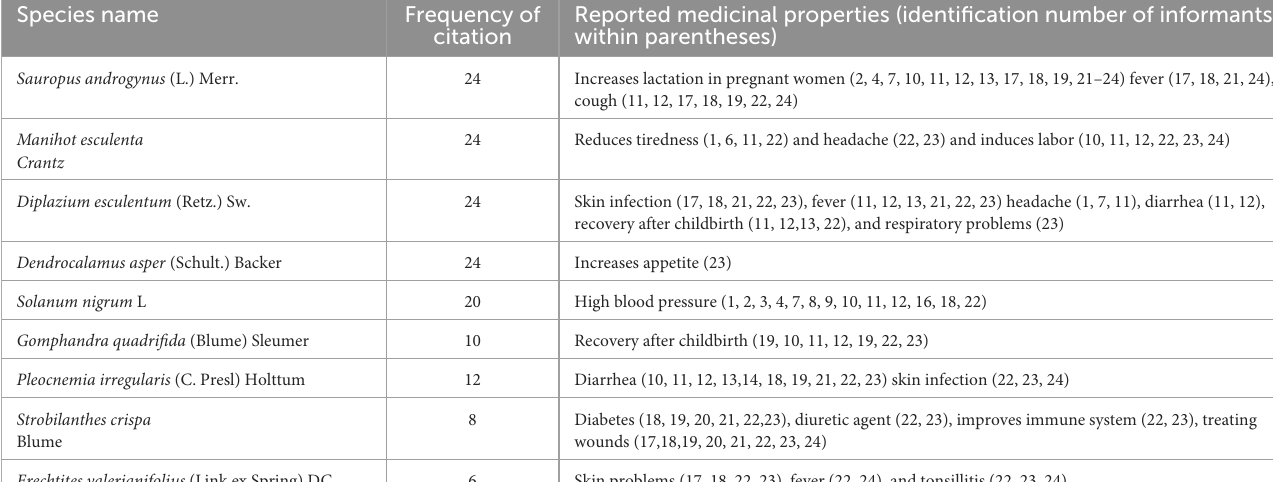
TABLE 3 Frequency of citation by informants, and medicinal uses.